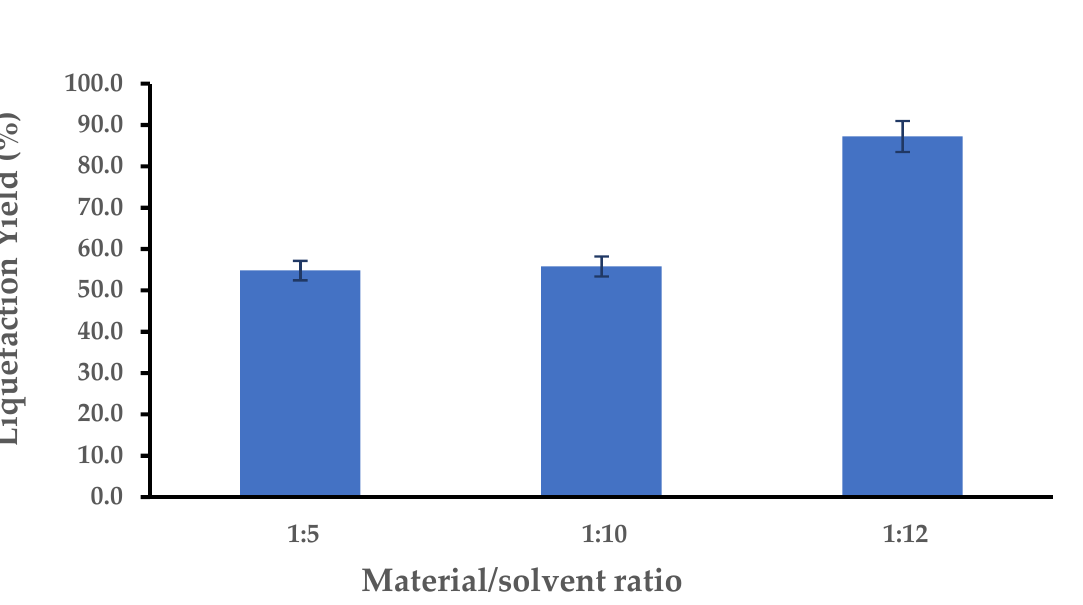
Figure 2. Study of the ratio CsB:solvent for the samples of the branches (CsB) of Cytisus scoparius (constant parameters: 180 ◦ C, time 60 min and size for the samples <80 mesh). Temperature optimization was performed by varying the temperature between 140 ◦ C and 180 ◦ C, keeping all other parameters constant. The results obtained are shown in Figure 3.